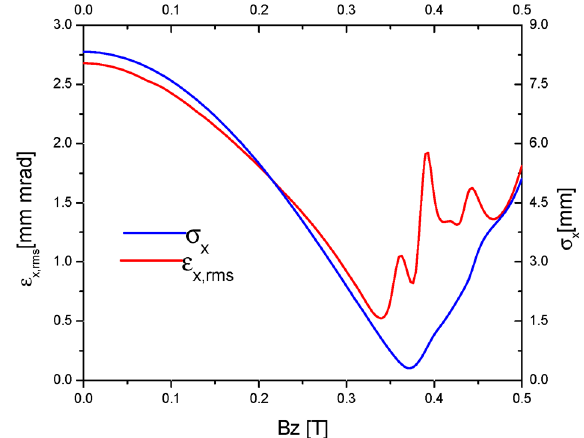
FIG. 4. (Color) Transverse emittance and beam size as a func- tion of the magnetic field amplitude at z (cid:1) 1 : 65 m . E max cell cavity. 50 MV = m . 2